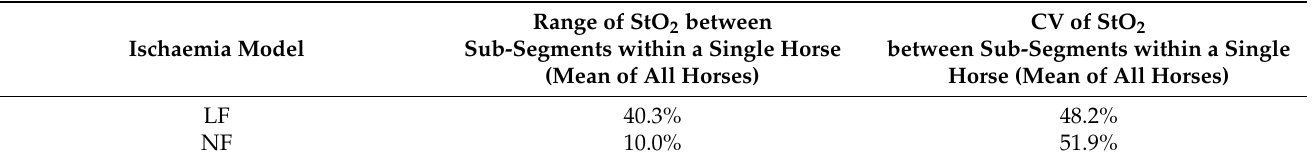
Table 3. StO 2 range and CV of the ischaemia in the intestinal sub-segments within one ischaemic segment of a single horse averaged per